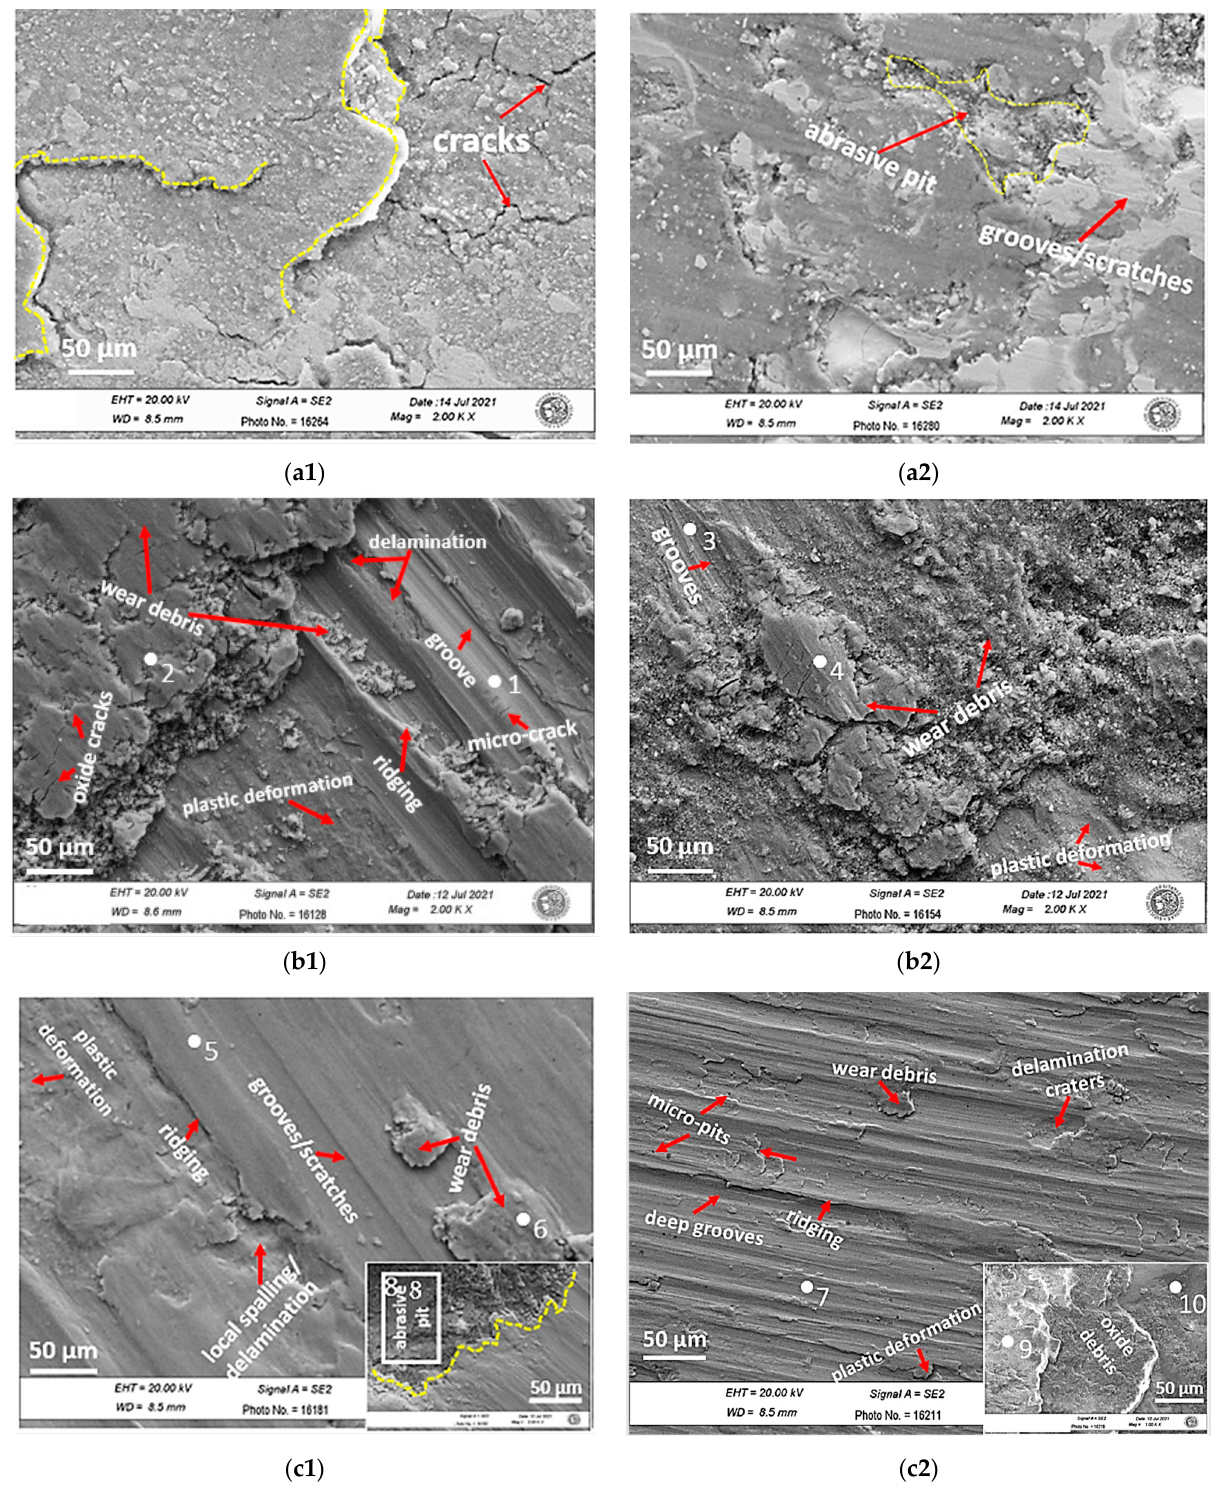
Figure 13. SEM micrographs of morphology of the wear scars and debris of the ( a1 ) HVOF- HEA_Mo 27 , ( b1 ) ESD-HEA_Mo 27 , ( c1 ) LC-HEA_Mo 27 and ( a2 ) HVOF-HEA_Mo 20 , ( b2 ) ESD- HEA_Mo 20 , ( c2 ) LC-HEA_Mo 20 coatings with the different deposition techniques after 12,000 wear cycles under dry test